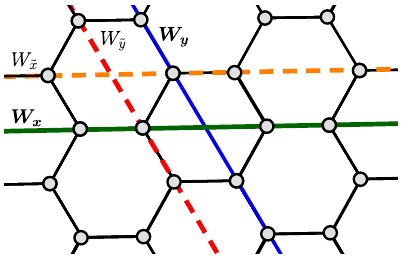
FIG. 2. The action of the commuting Wilson loop operators W x and W is shown above as the product of the Majorana fermions y on the lattice sites intersected by the appropriate colored lines. The operator W ~ anticommutes with W and takes the ground y x state between two topological